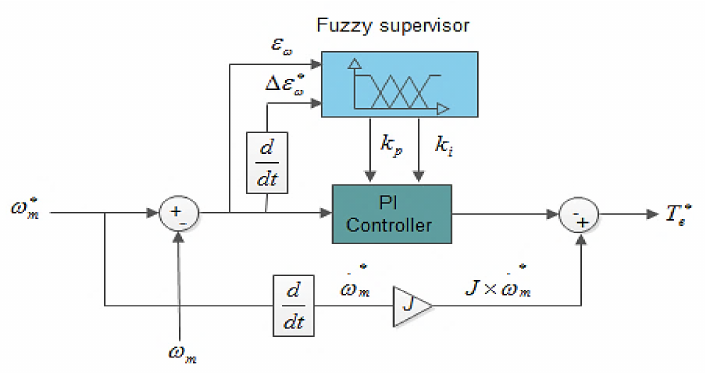
Figure 5. Fuzzy gain supervisory PI